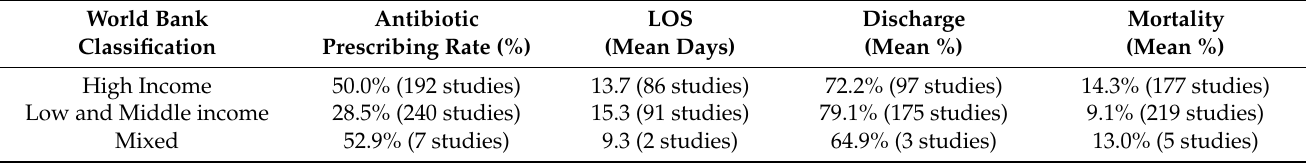
Table 6. Study country by national economic status, antibiotic prescribing and health outcomes in COVID-19 patients.